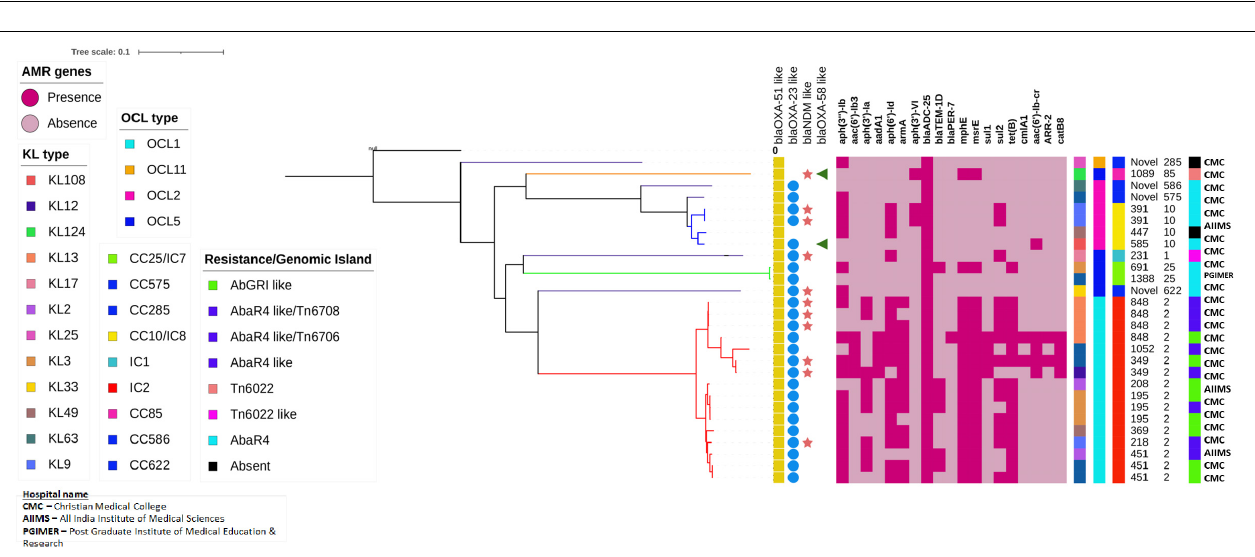
FIGURE 8 | Structures of Tn 6022 and Tn 6022 -like elements. The typical Tn 6022 backbone is shown at the top of the figure. Tn 6022 -derived element observed in this study is displayed at the bottom of the figure and showed the insertion of IS Aba42 (red arrow) with an additional orf . Appropriate names of the elements found within the genetic configurations are given. Dotted lines in red are used to depict the insertion of genetic elements.